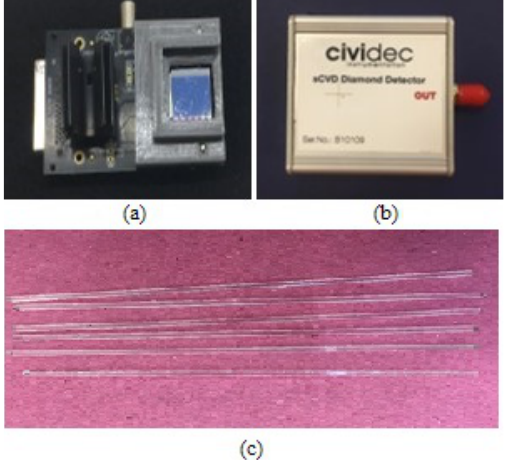
Fig. 5. Detectors of METU-DBL (a) Timepix3 pixel detector, (b) diamond detector (c) fiber scintillator.